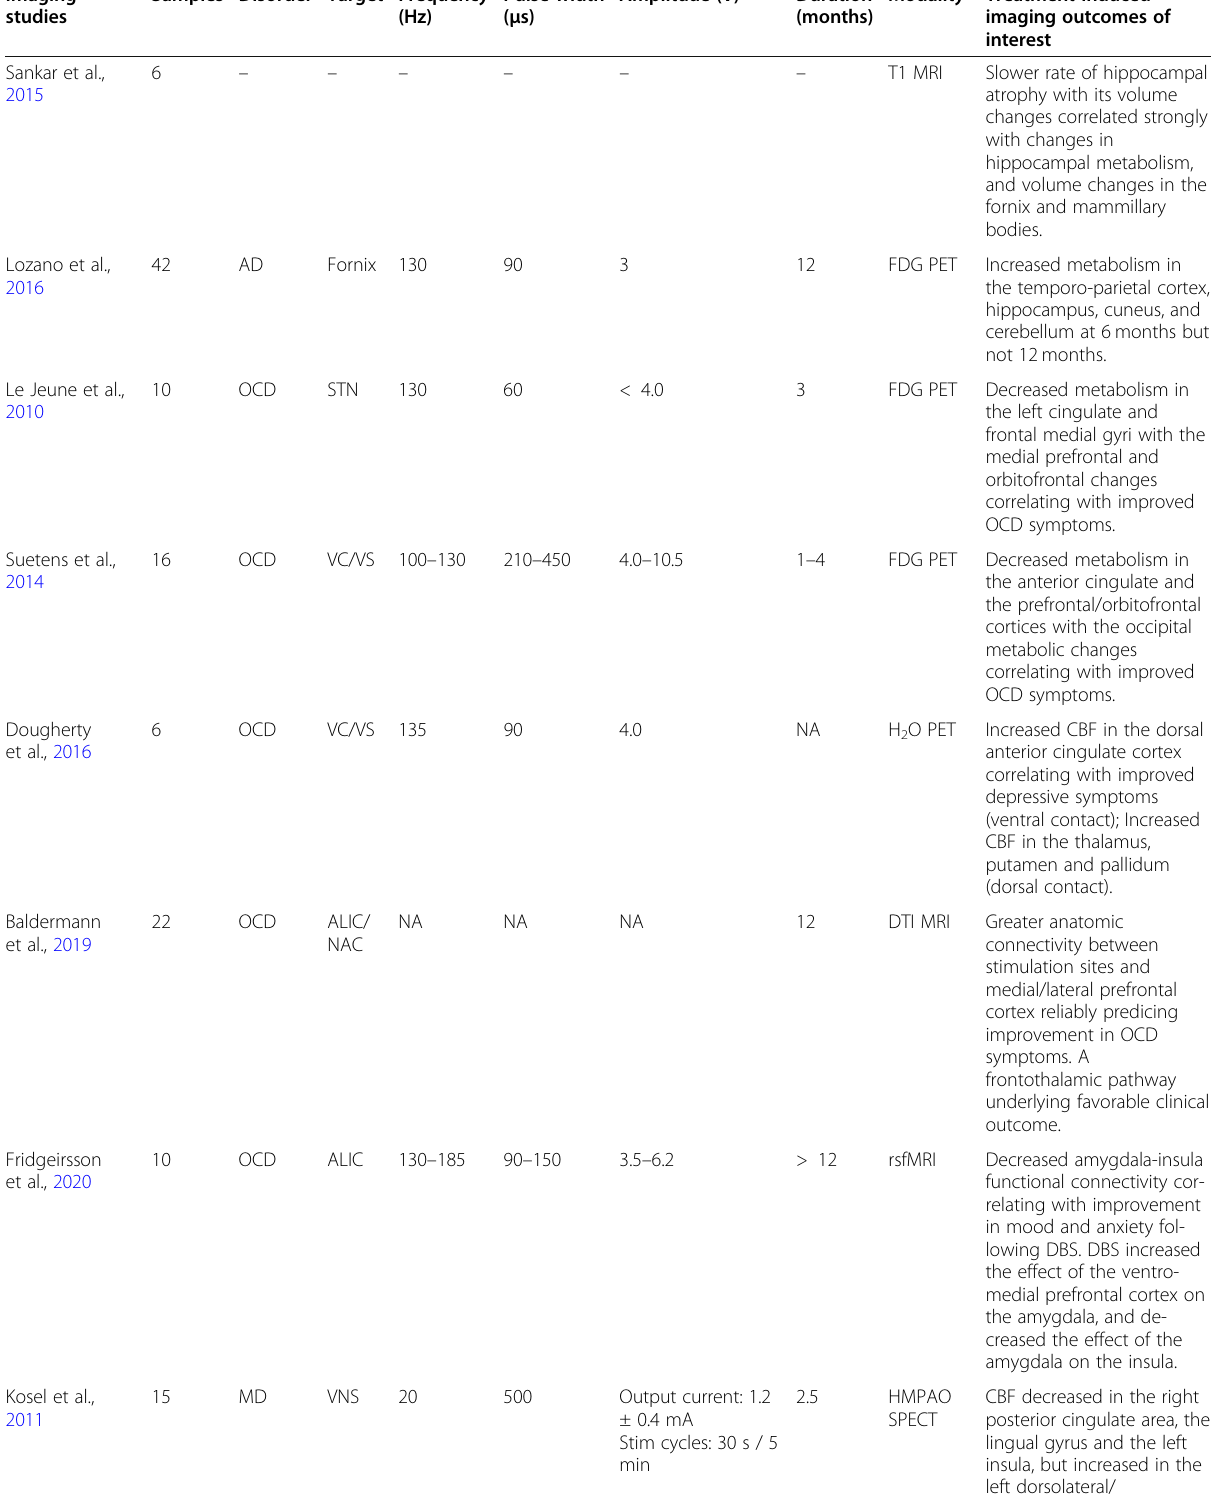
Table 1 Clinical characteristics and primary imaging outcomes of deep brain stimulation therapies in select neurodegenerative and psychiatric disorders (Continued) Imaging